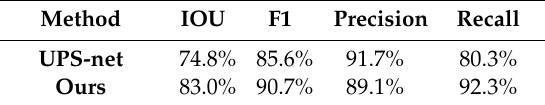
Table 4. Precision, recall, F1, and IOU scores on the test data of the comparative